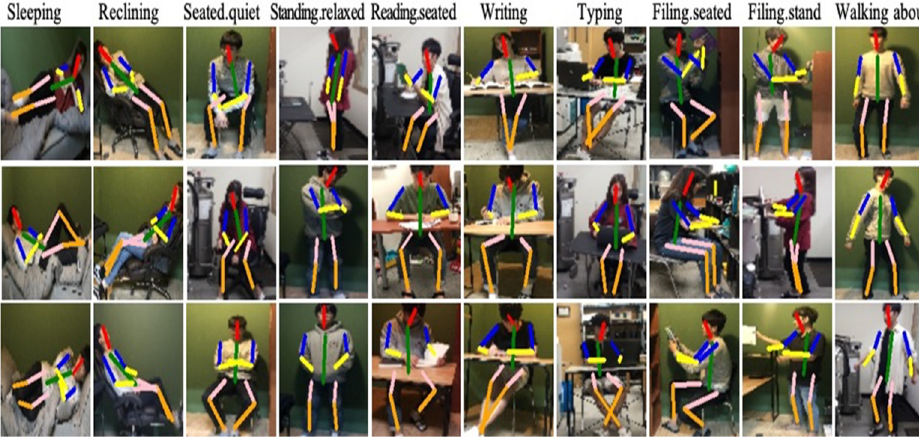
Figure 10. Examples of estimated body parts of test dataset.